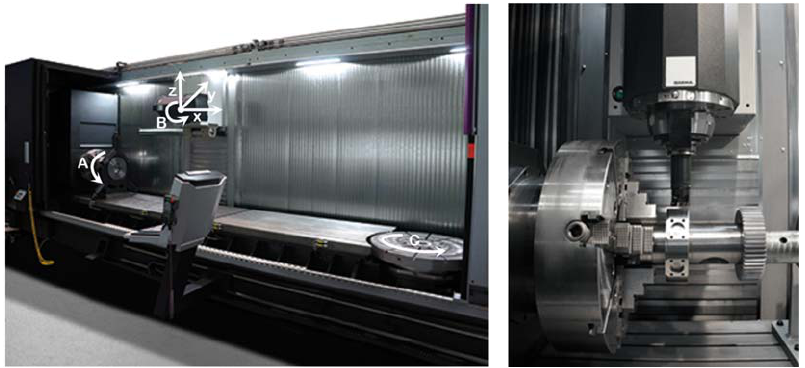
Figure 5. Ibarmia multiprocess machine ZVH38/L1600 ( left ), Ibarmia ZVH38/L1600 A axis and head ( right ).